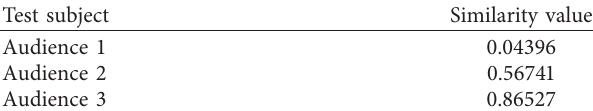
Table 1: Experimental results of the model.